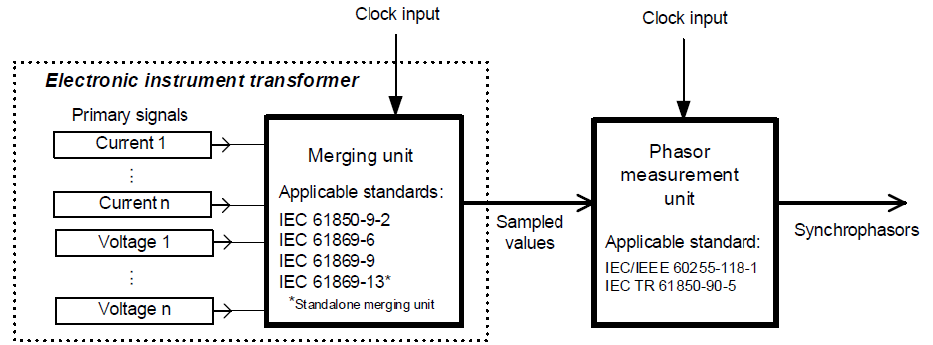
Figure 1. Measurement chain for synchrophasor measurements based on Sampled Value inputs, as per IEC/IEEE